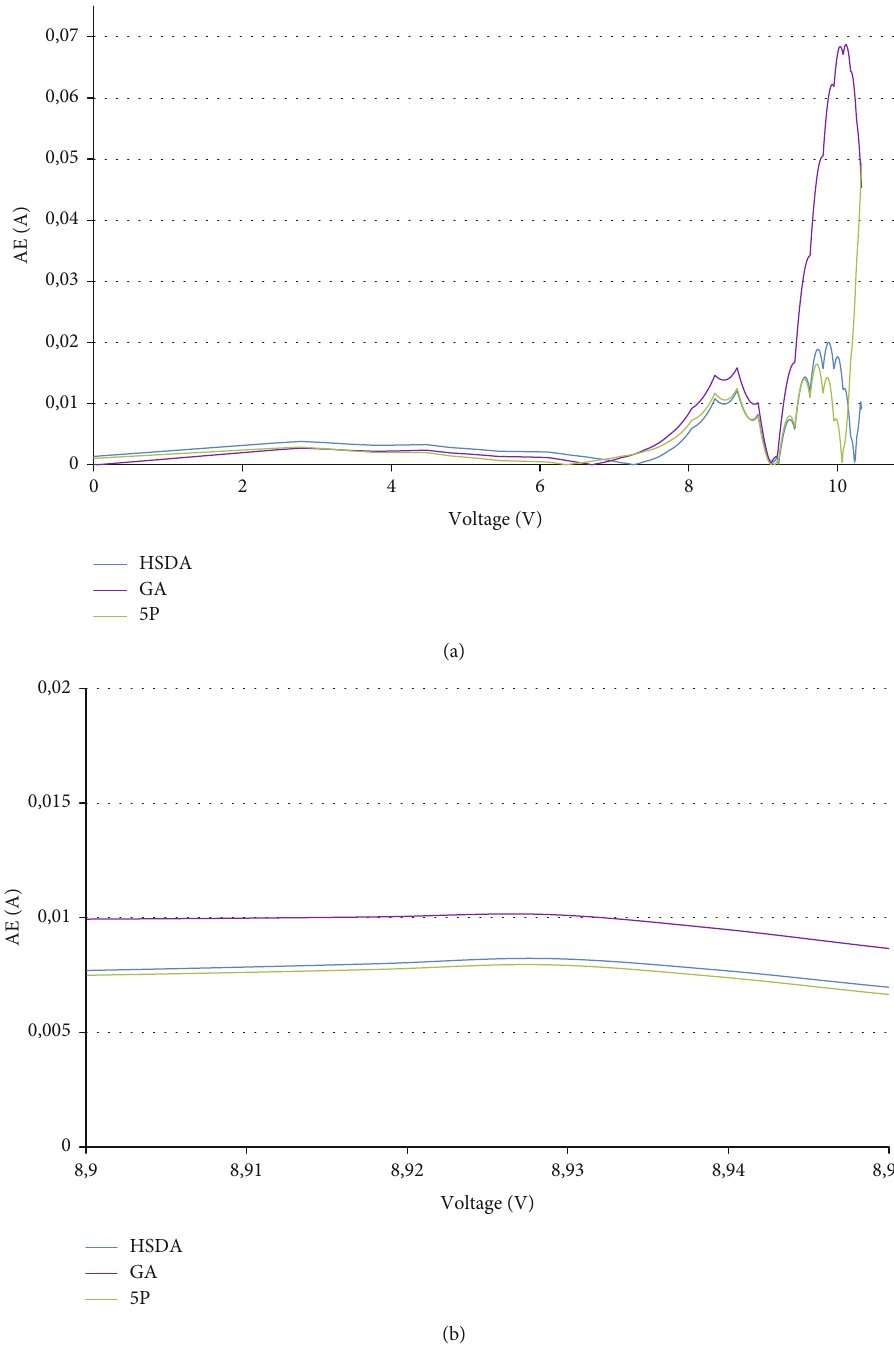
Figure 8: (a) The absolute current error (AE) for the forecasted I - V characteristic for photovoltaic panel; (b) AE in the voltage which corresponds to maximum power region.